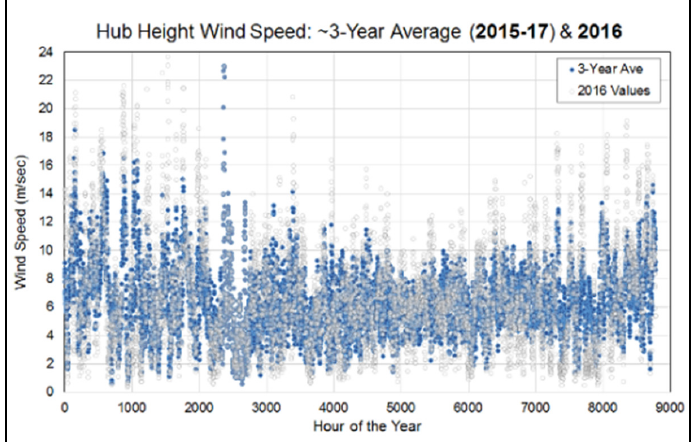
Figure 5. Wind speed time series for Tilos island.